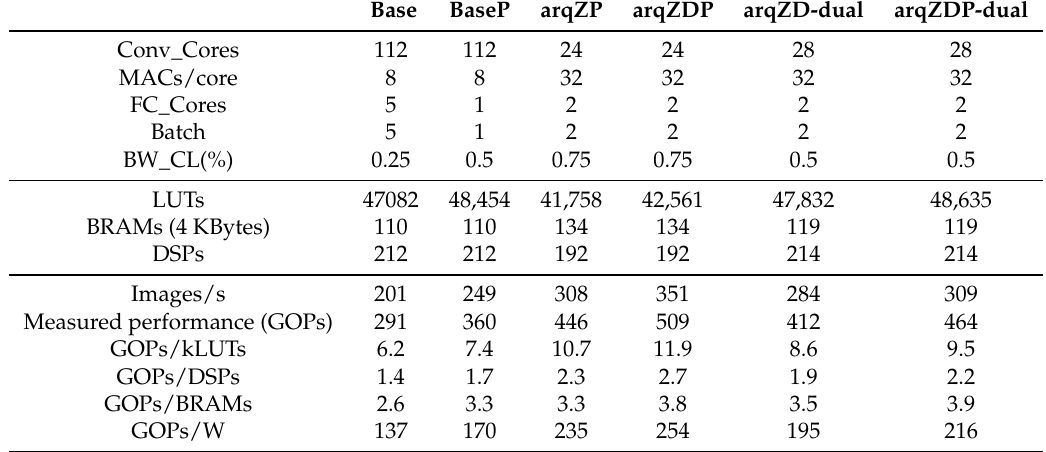
Table 1. Results of the architectures running the inference of AlexNet in a ZYNQ XC7Z020 FPGA.